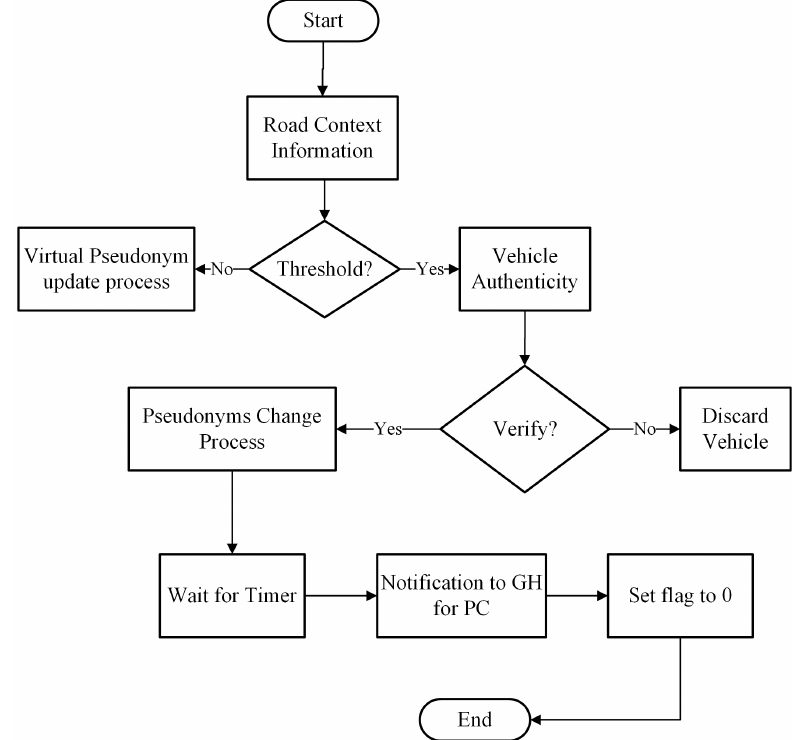
Figure 7. Flow of pseudonym update process.